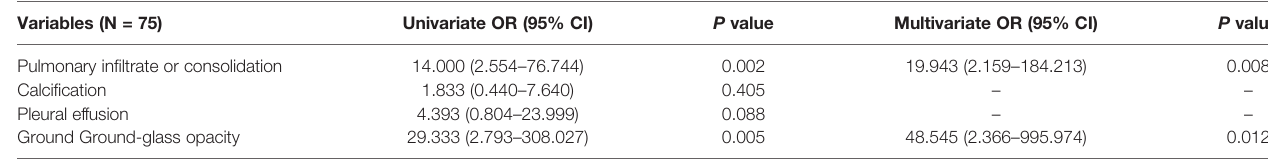
TABLE 7 | Univariate and multivariate binary logistic regression analysis showing independent radiologic predictors of respiratory failure in pregnant